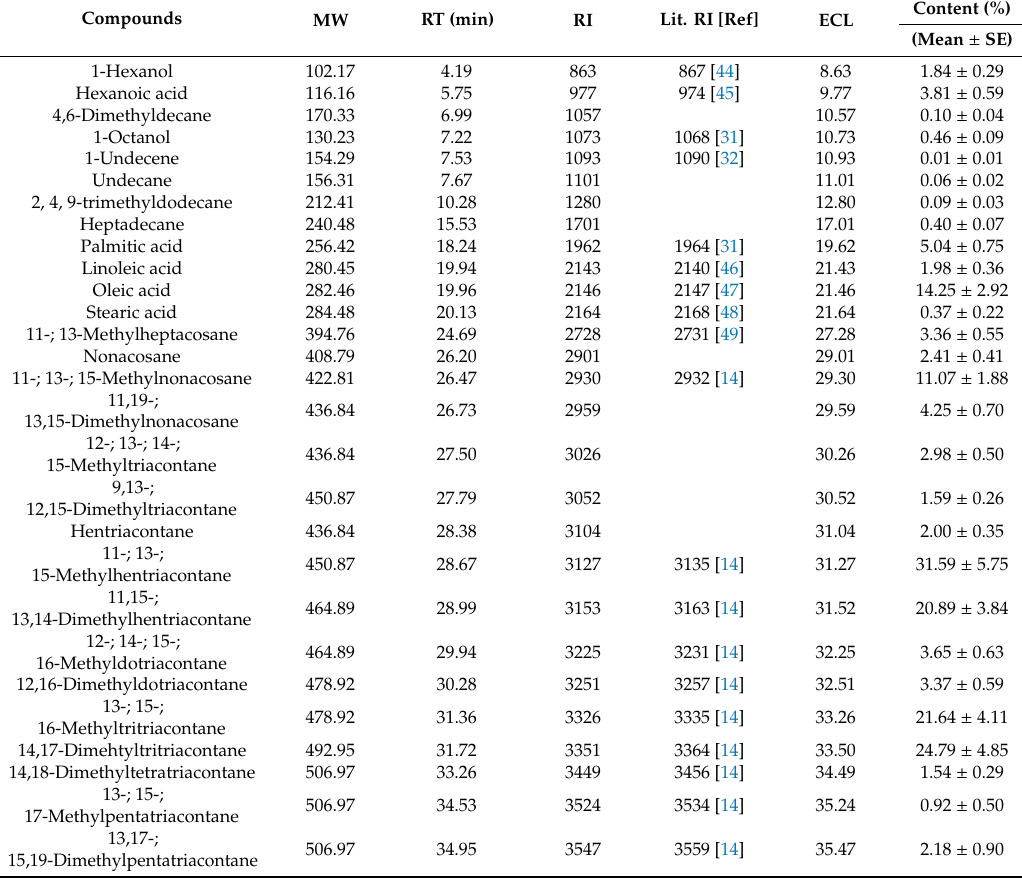
Table 4. Compounds isolated from the head of the workers of Oecophylla smaragdina.